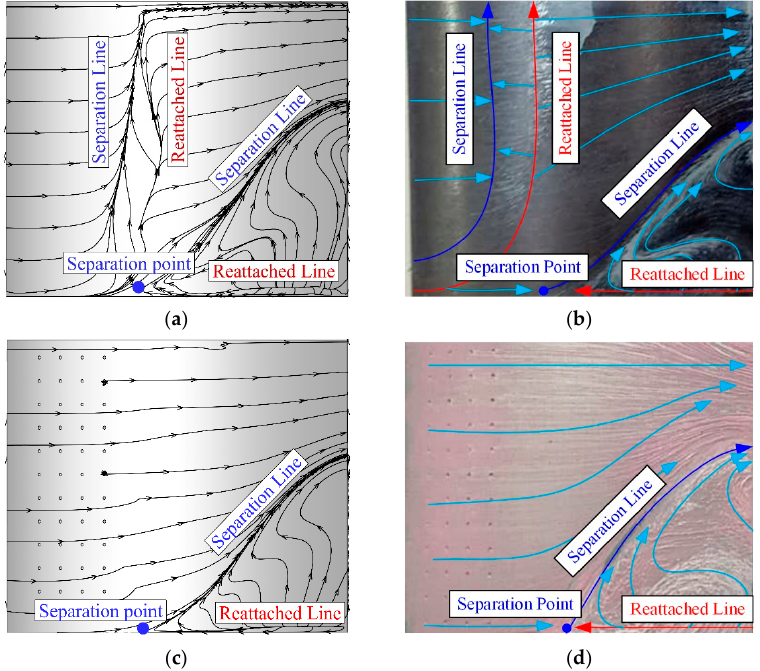
Figure 9. Limiting streamline on the suction surface of numerical and experimental results (DIM represents the case of λ = 0.375 ). ( a ) CFD-ORI; ( b ) EXP-ORI; ( c ) CFD-DIM; ( d ) EXP-DIM.